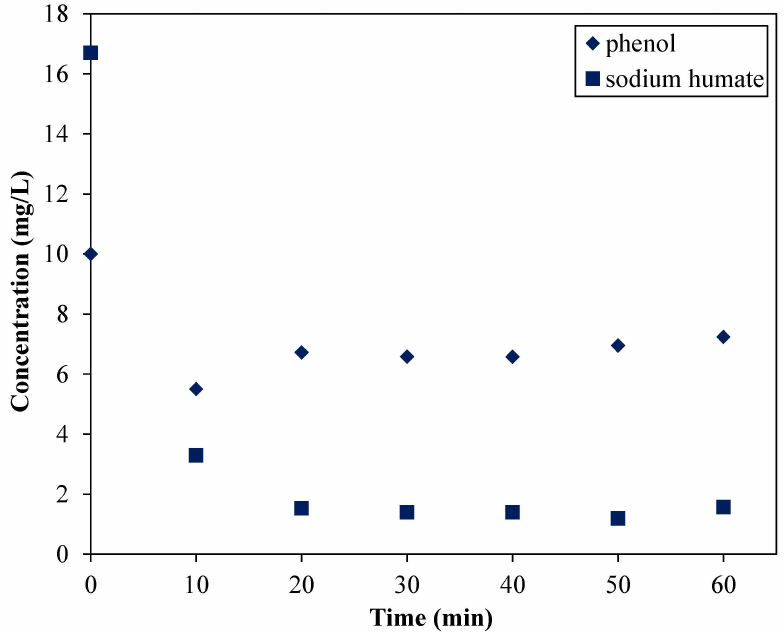
Figure 7. The effect of changing the input sequence—in this case, the following order was implemented 1: phenol; 2: sodium humate; 3: clay mineral; 4: cationic surfactant. In the second experiment, the next order was applied: 1: sodium humate; 2: clay mineral; 3: phenol; 4: cationic surfactant (Figure